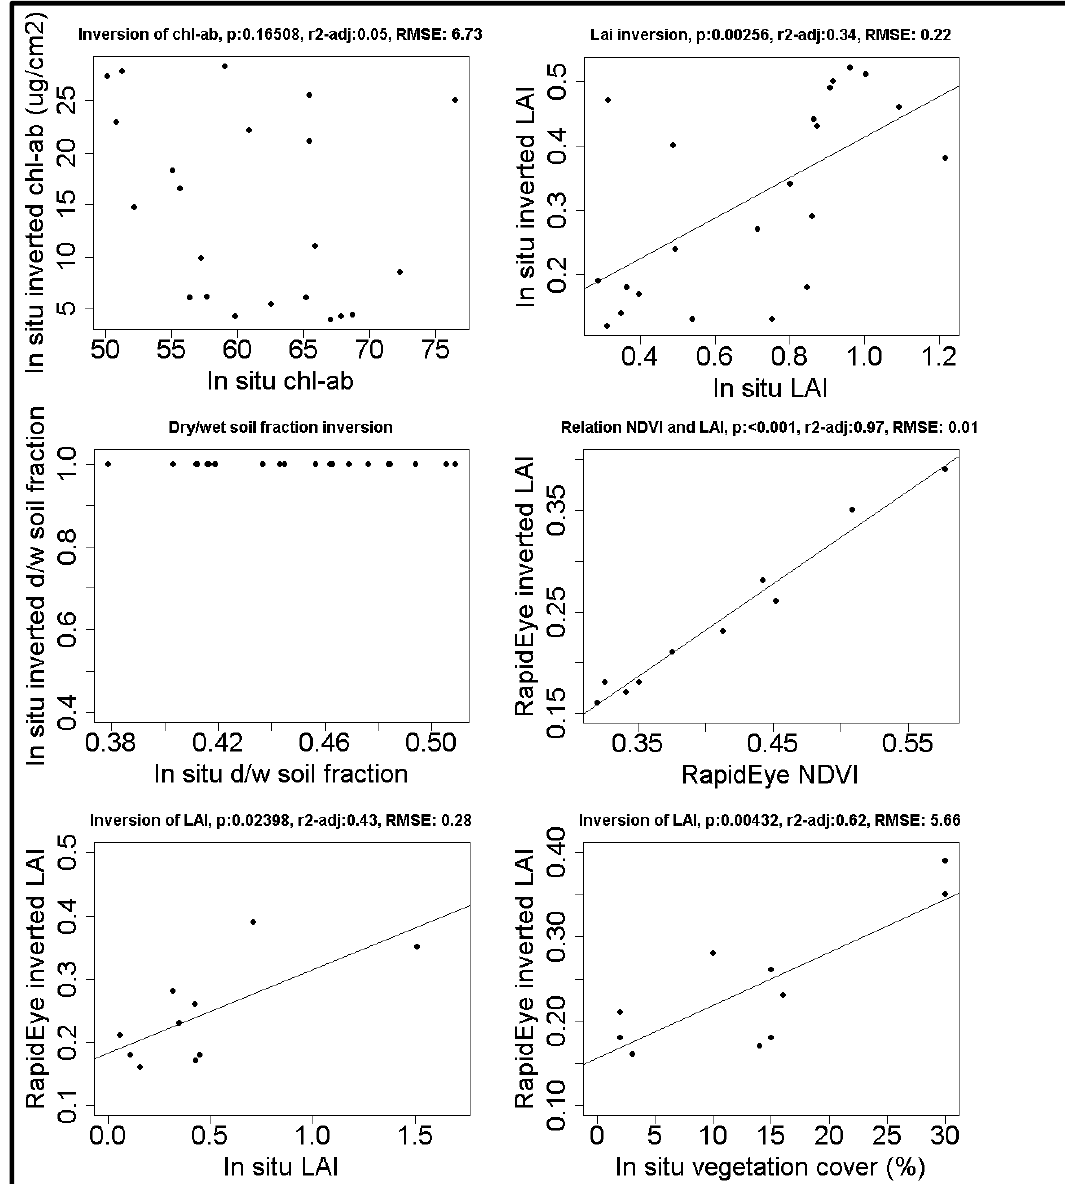
Figure 3. The first three graphs show the relation between in situ measurements and the model inversion of in situ spectra. The fourth graph shows the relation between the LAI inversion and NDVI both based on satellite spectra. The final two graphs show the model inversion of satellite spectra with in situ measurements of LAI and vegetation cover. Regression lines are shown for significant relationships p <